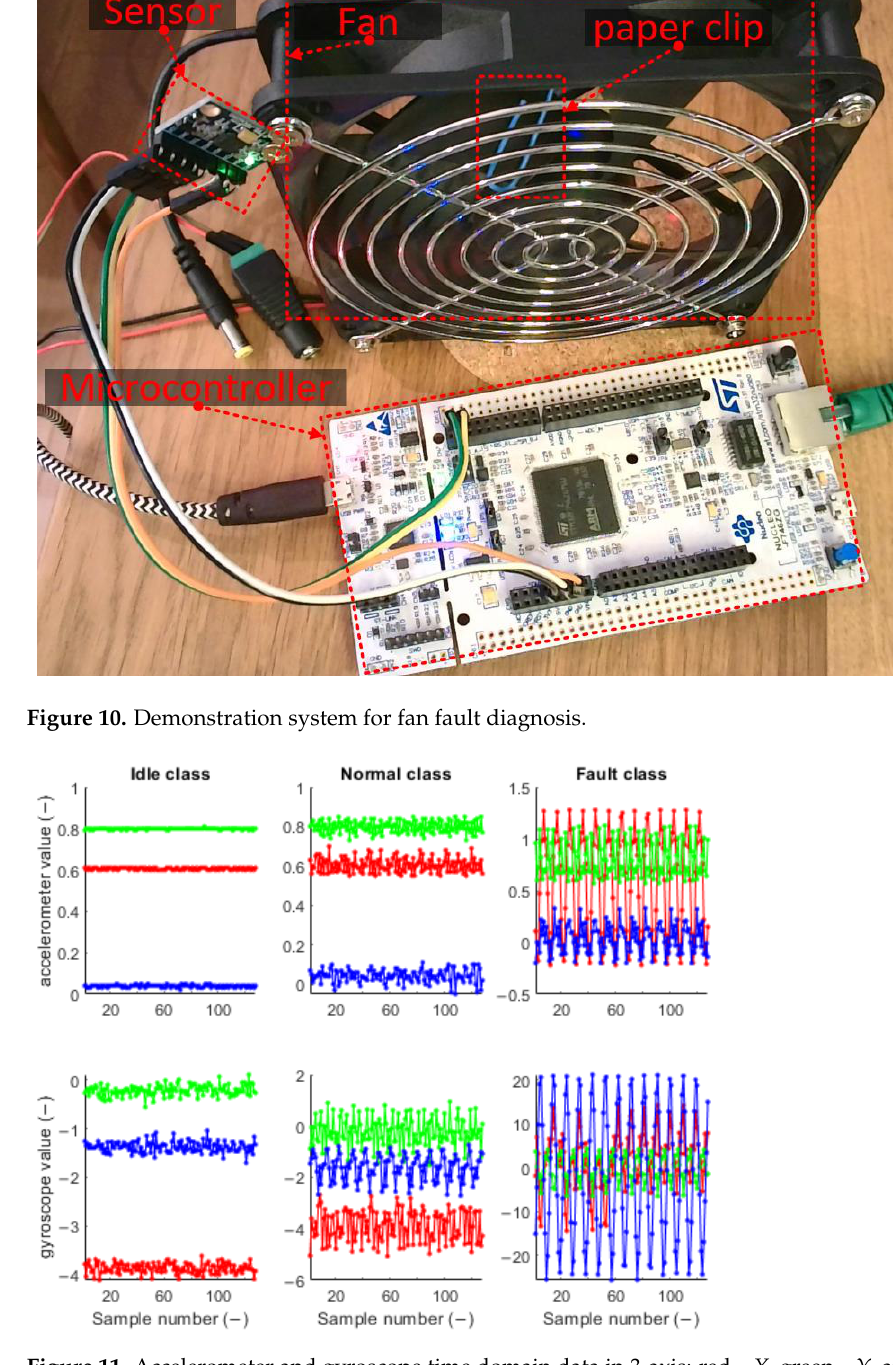
Figure 12. Accelerometer and gyroscope frequency domain data in 3-axis: red— X , green— Y , and blue— Z . The second stage of preparation was the extraction of features using mSDFT [153]. Each step of mSDFT returns 33 complex numbers at frequencies in the range from 0 Hz to 100 Hz. The algorithm was implemented in MATLAB and the absolute values of the com- plex number were stored in the files. Each row of the file contains 33 points that were used as a feature vector. The sliding discrete Fourier transform result can be gathered after each new sample. The multiple spectrums calculated at different times are shown in Figures 13 and 14. The time–frequency analysis showed that for each class, the dominant frequency components are constant and do not vary with time.